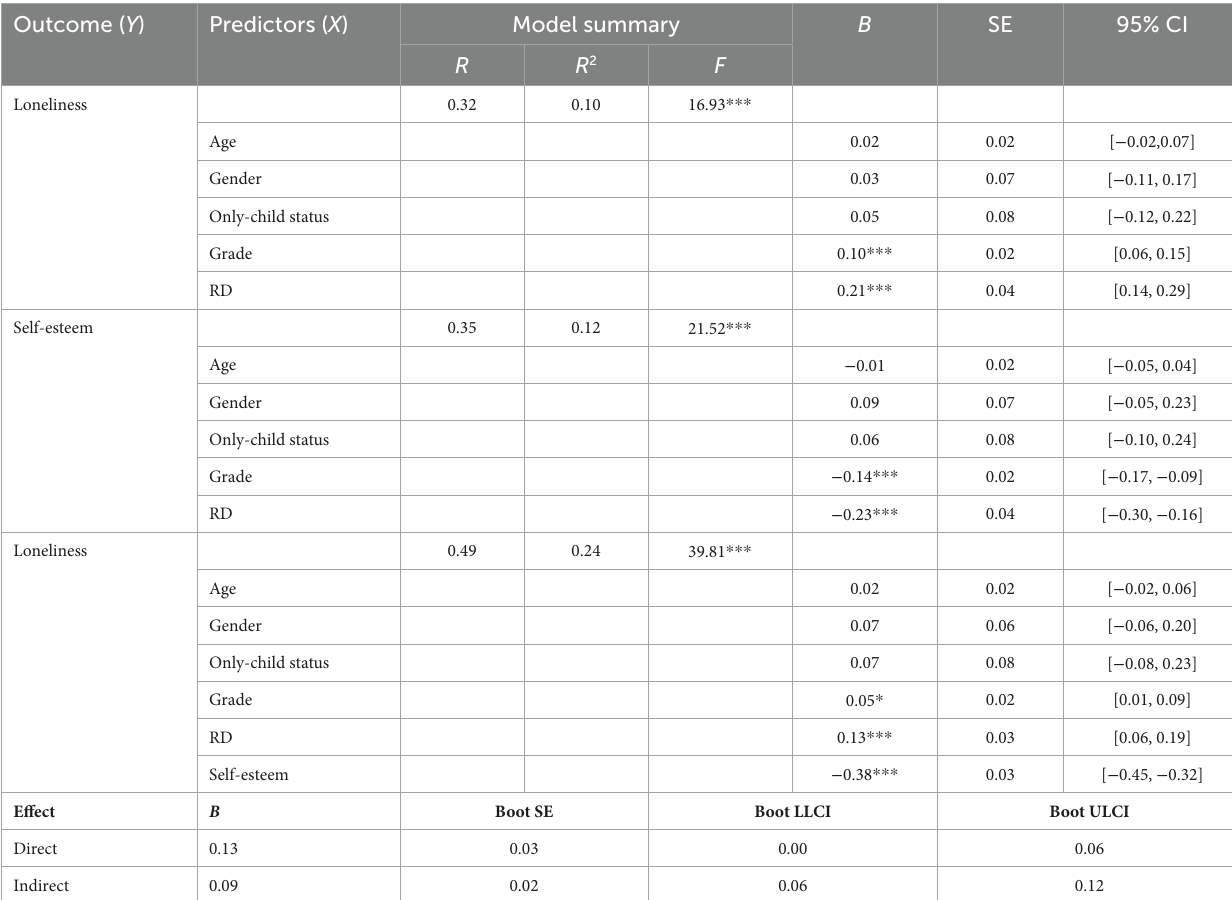
TABLE 7 Robustness test: testing the mediation effect of self-esteem. Outcome ( Y